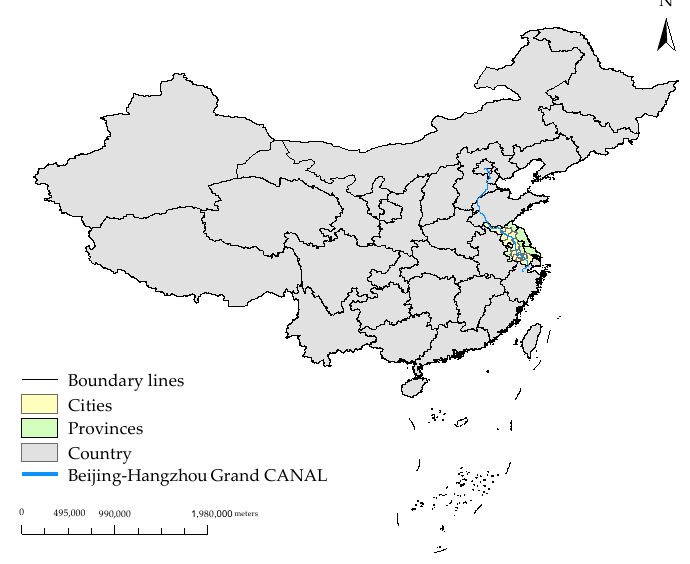
Figure 1. Drainage map of the Beijing–Hangzhou Canal.